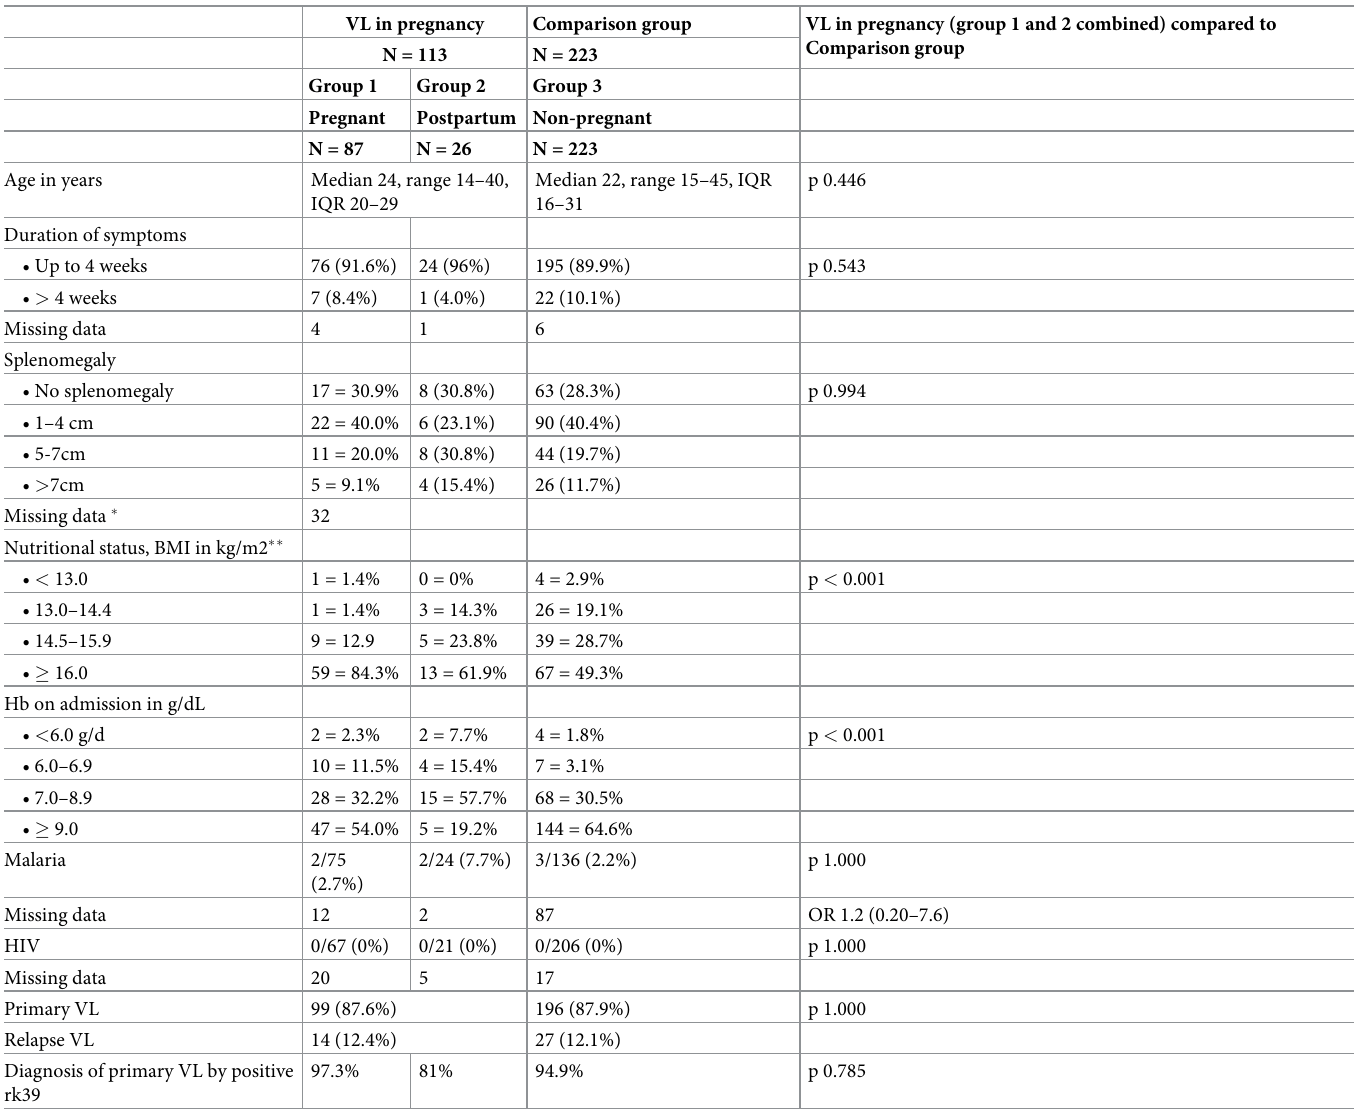
Table 1. Patient characteristics on